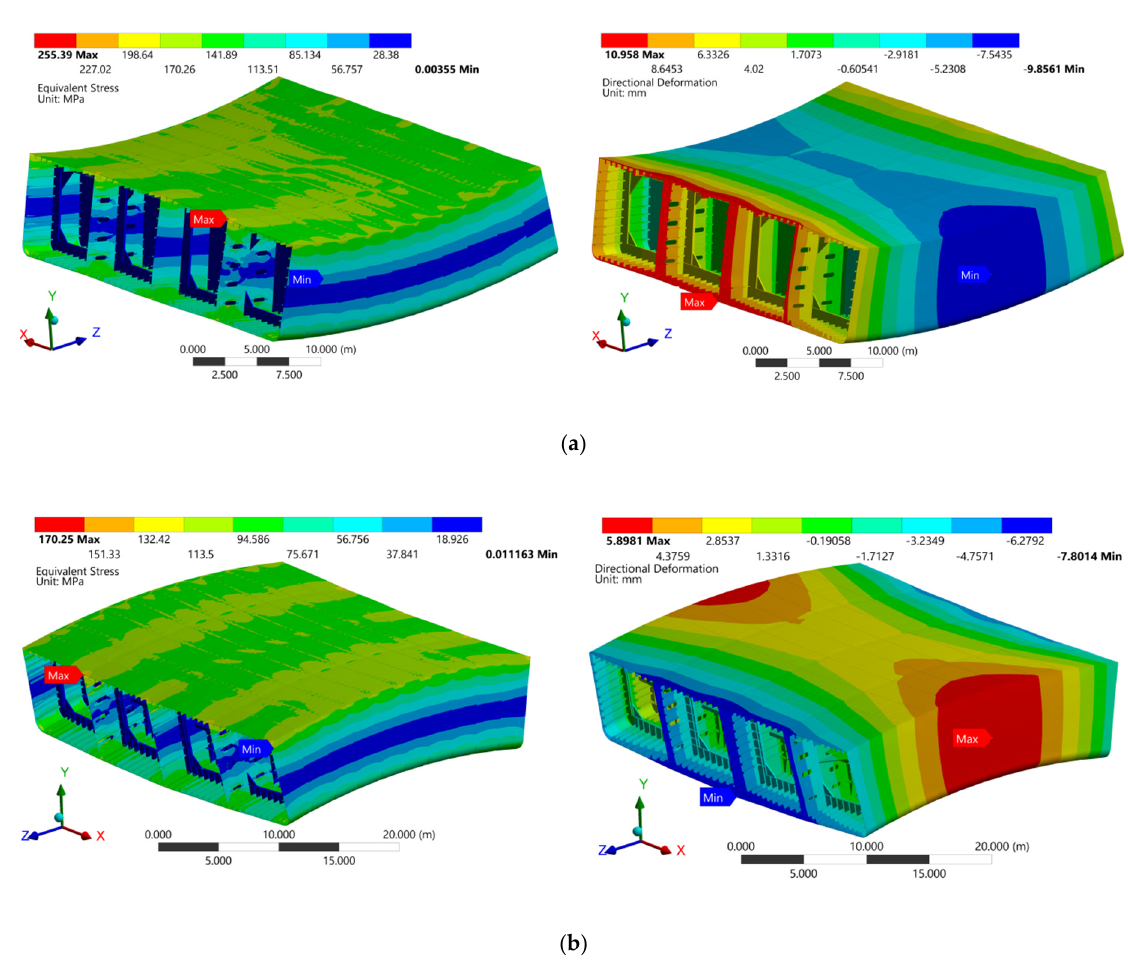
Figure 13. Results of von Mises stresses (left) and displacements (right) of the FEM model of barge midship section considering ( a ) sagging bending moment of 906.88 × 10 6 Nm and ( b ) hogging bending moment of 599.10 × 10 6 Nm. Table 5. Parameters of barge determined using Lloyd’s Register rules.